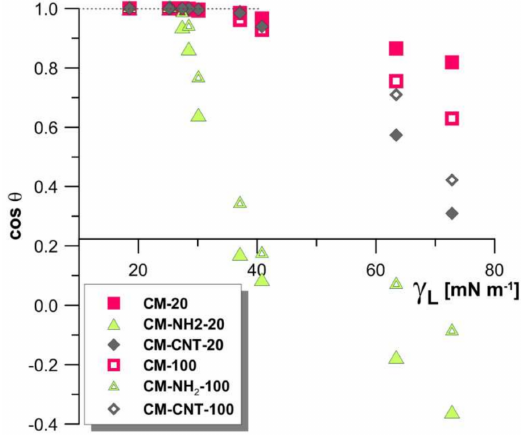
Figure 12. Zisman plot of pristine and modified